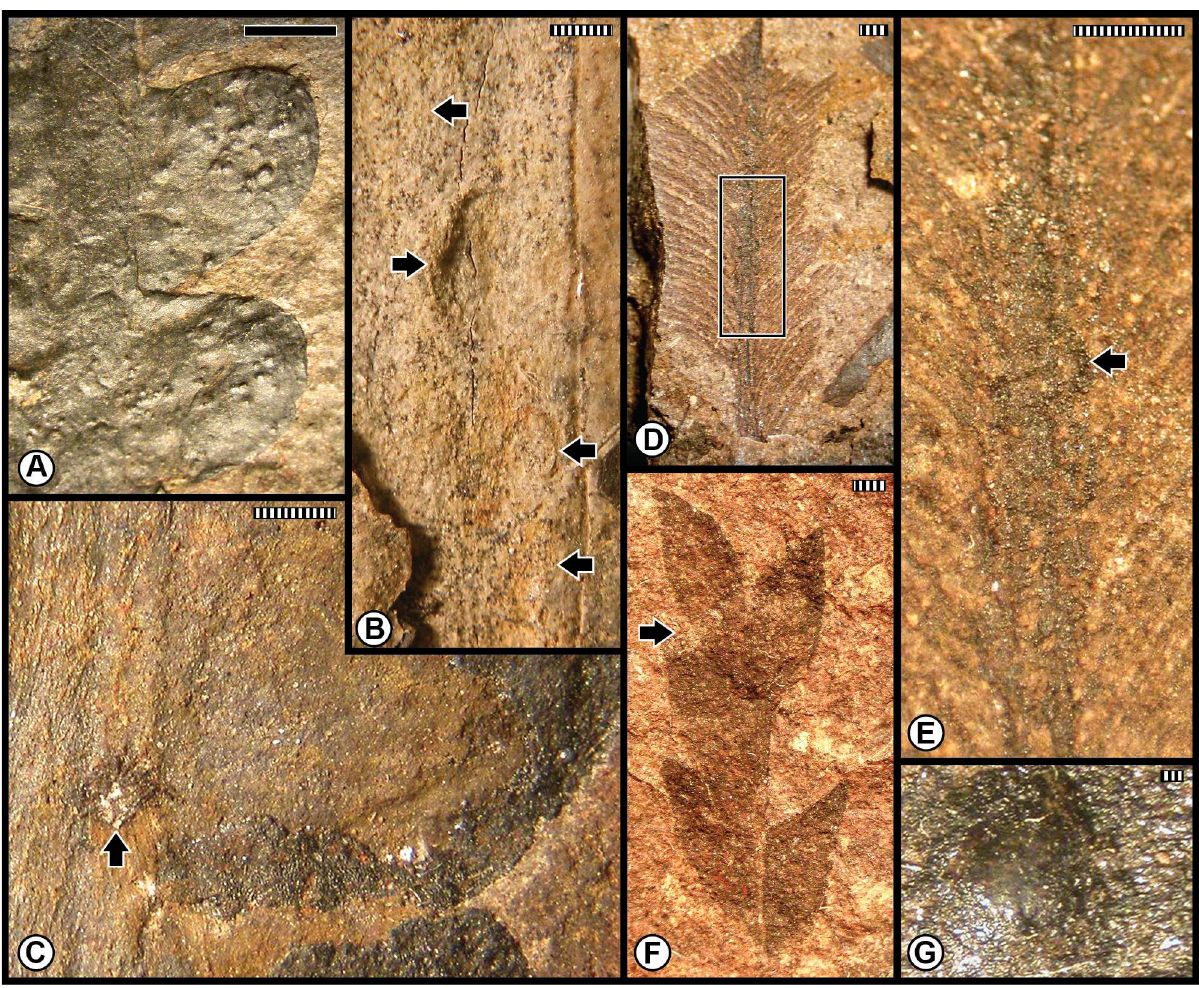
Fig 11. Plant–insect interactions from the Middle Triassic (Ladinian) Forcella da Cians/Ritberg Flora, of the Agordo Formation near Wengen/La Valle, St. Veit-Seewald, within the Fernazza Formation, and St. Veit-Innerkohlbach, near Prags/Braies, within the Wengen/La Valle Formation in the northern Dolomites. A : The pteridosperm Ptilozamites sandbergeri showingabundantDT80 galls along the leaf surface. Specimen PAL-1516 (St. Veit-Innerkohlbach). B : Successive, end-to-endoviposition marks (DT175) on a Ptilozamites sandbergeri rachialmidvein, showinga series of four lesions (arrows). SpecimenPAL-202 (Forcela da Cians). C : Oviposition (DT76) on the rachial midvein of another specimenof Ptilozamites sandbergeri . Specimen PAL-11 (Forcela da Cians). D : A pinnuleof Marattiopsis sp., showingdevelopment of a leaf mine (DT222) adjacent to the primary vein. Specimen PAL-231 (St. Veit-Innerkohlbach). E : Enlargement of midvein-centered leaf mine (DT222) in the rectangular template in (D). Arrow shows the mine frass trail along the midrib. F : The fern Cladophlebis leuthardtii ,with a small example of cuspate margin feeding (DT12). Specimen PAL-73 (St. Veit-Innerkohlbach). G : Foliar gall (DT32) on a fourth specimen of Ptilozamites sandbergeri . Specimen PAL-18 (Forcela da Cians). All specimens are reposited in the Museum of Nature South Tyrol (MNS), in Bolzano, Italy. Scale bars: striped = 1 mm; solid = 10